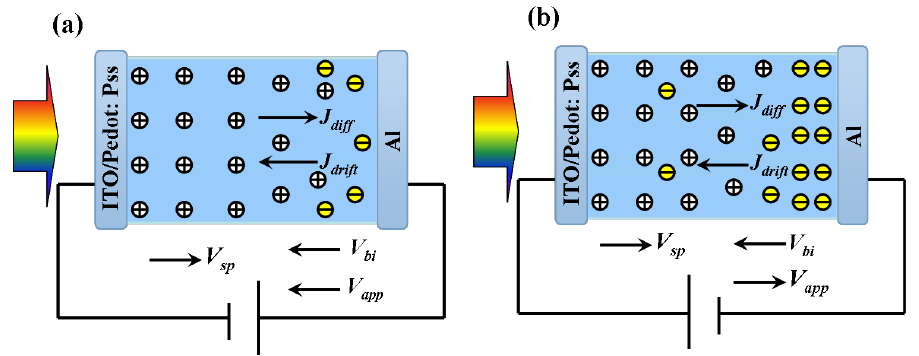
Figure 3. The schematic diagram of the carriers’ motion under illumination ( a ) when V app < 0 ( b ) when 0 < V app < V bi. 0 < V app < V bi